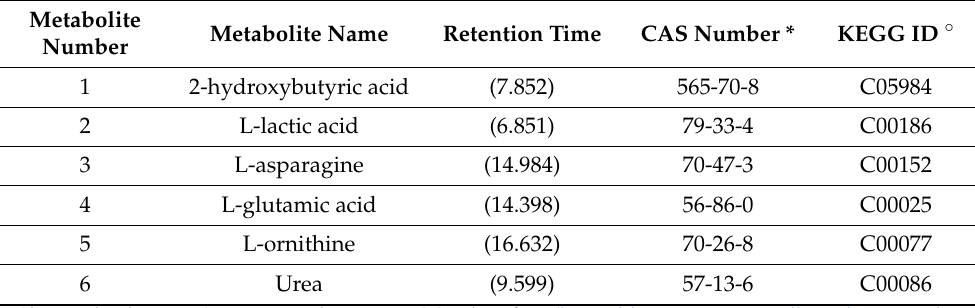
Figure 2. Plasma metabolomic profile using gas chromatography–mass spectrometry (GC-MS). Histogram representation of plasma metabolites whose relative abundance is statistically different between basketball athletes and controls ( p value < 0.05). Table 2. List of metabolites with significant differences between female basketball players and controls, identified by gas chromatography–mass spectrometry (GC-MS) analysis.